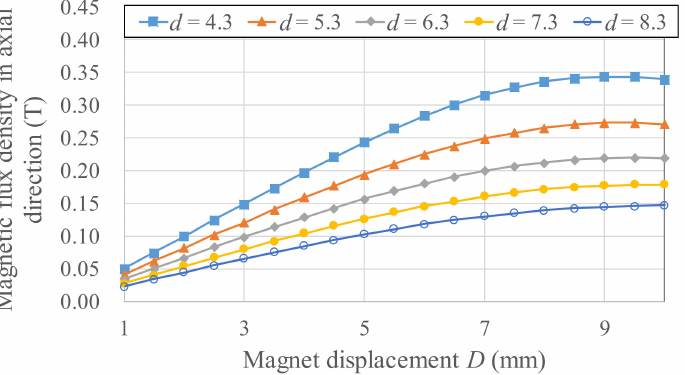
Figure 10. Results of using COMSOL Multiphysics to simulate b , d , and D , the Wiegand wire axial average magnetic flux density.